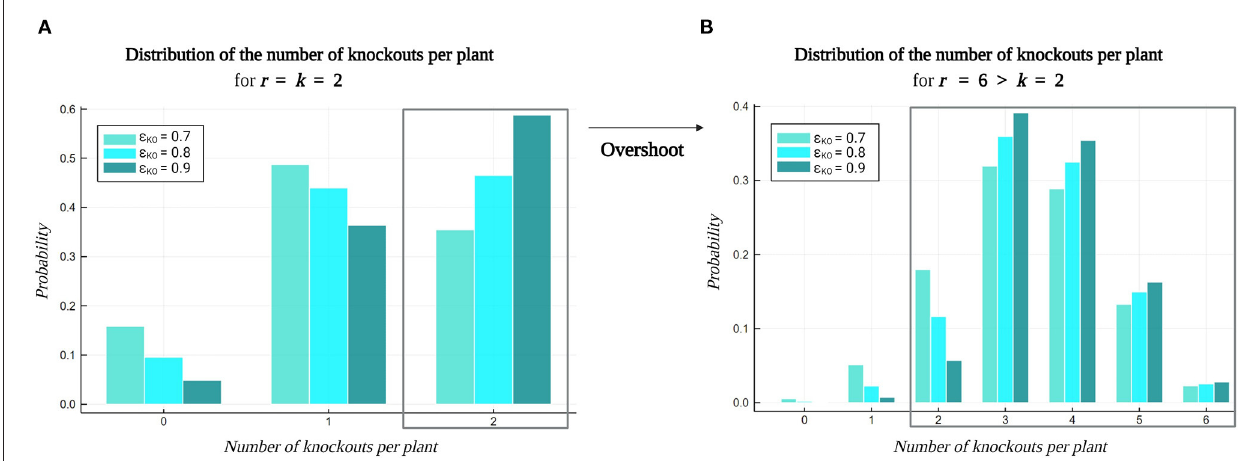
FIGURE 9 | Impact of the Overshoot–Select–Purify strategy on the distribution of the number of knockouts per plant. A multiplex CRISPR/Cas experiment investigating pairwise combinations ( k = 2) of gene knockouts for a set of 20 target genes was considered (see default settings in Table 2 ). The probability of the number of gene knockouts per plant is dependent on the global gene knockout efficiency ǫ KO . (A) The standard multiplex CRISPR/Cas approach incorporates r = k gRNAs per vector in the construct library, producing a plant library containing wildtypes, single and double knockout lines, as a result of inefficiencies related to CRISPR/Cas-mediated genome editing. (B) Applying Overshoot ( r > k ) yields a diverse library of plants containing relevant combinations of gene knockouts of an order that ranges from k to r